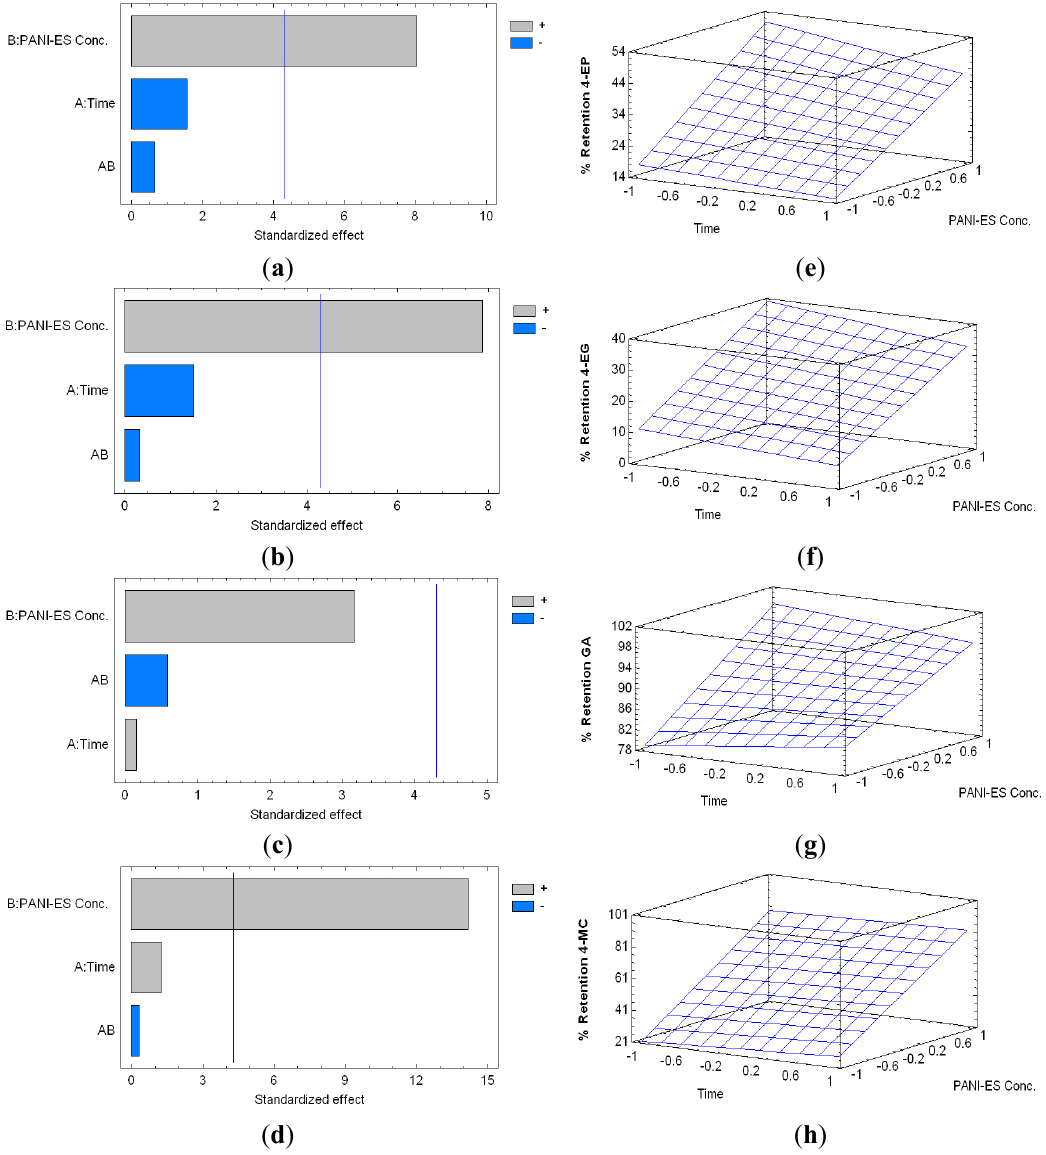
Figure 5. Standardized Pareto charts for Percentage of Retention of 4-EP ( a ); 4-EG ( b ); GA ( c ) and 4-MC ( d ), by PANI-ES treatment, respectively (Where: A, time of reaction; B, concentration of PANI-ES; and AB, interaction. The blue line represents the critical t -value, 95% confidence, with 10 total degrees of freedom); and estimated response surfaces of 4-EP ( e ); 4-EG ( f ); GA ( g ) and 4-MC ( h ) retention.